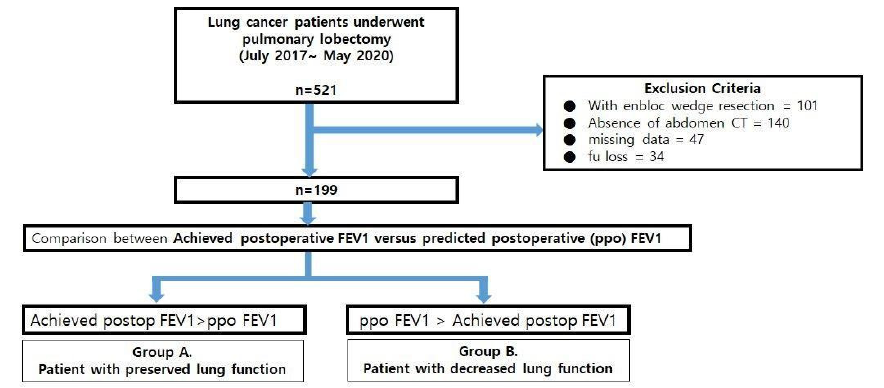
Figure 1. The flow chart of the study. 2.3. Comparison between Predicted Postoperative Lung Function after Lobectomy(ppo FEV1%) and Measured Lung Function after Lobectomy (Achieved Postoperative FEV1%: apoFEV1%) FEV1 using a segmental method as follows:ppo FEV1(%) = preoperative FEV1 × remaining